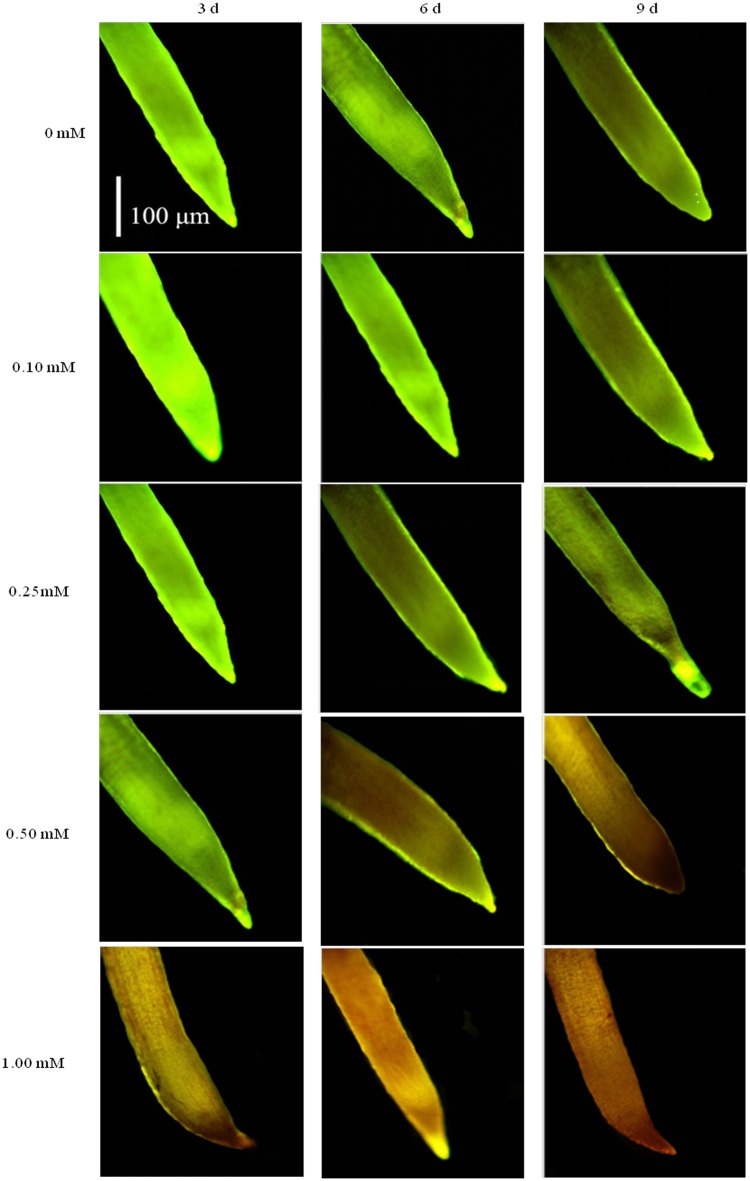
Effects of DHAP on root tips viability of P. schrenkiana seedlings tested by FDA-PI staining.